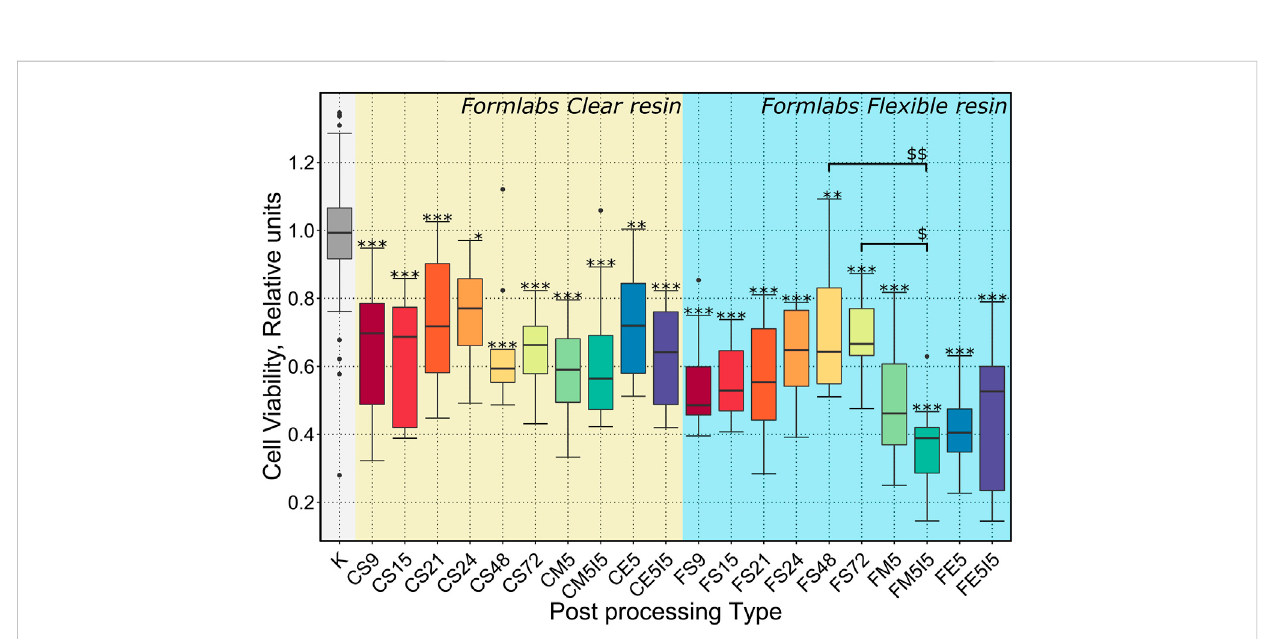
FIGURE 4 Resultsofaquantitativebiocompatibilitystudy.ThecellviabilityresultspresenteddependingonthetreatmentsperformedaftertheadditionalUVexposure (22 h):S9,S15,S21,S24,S48,S72-soakinginaSoxhletextractorfor9,15,21,24,48,72 h;M5-soakinginmethanolfor5days;E5-soakinginethanolfor5days; M5I5-soakinginmethanolandisopropanolfor5days;E5I5-soakinginethanolandisopropanolfor5days F- FormlabsFlexible ,C- FormlabsClear .K-control. *** indicates a p -value of < 0.001 for the samples compared to the control, while $$ indicates a p -value of < 0,01 between the indicated samples and * ( $ ) indicates a p -value of <